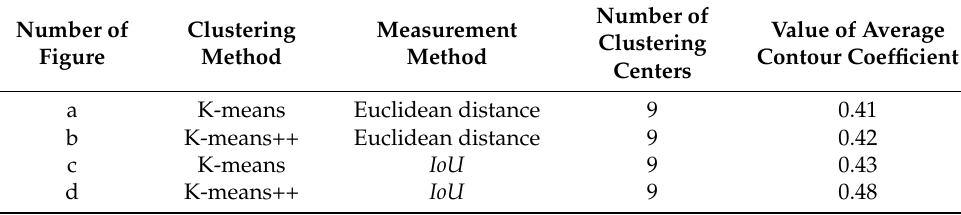
Table 5. Comparison of clustering effects.